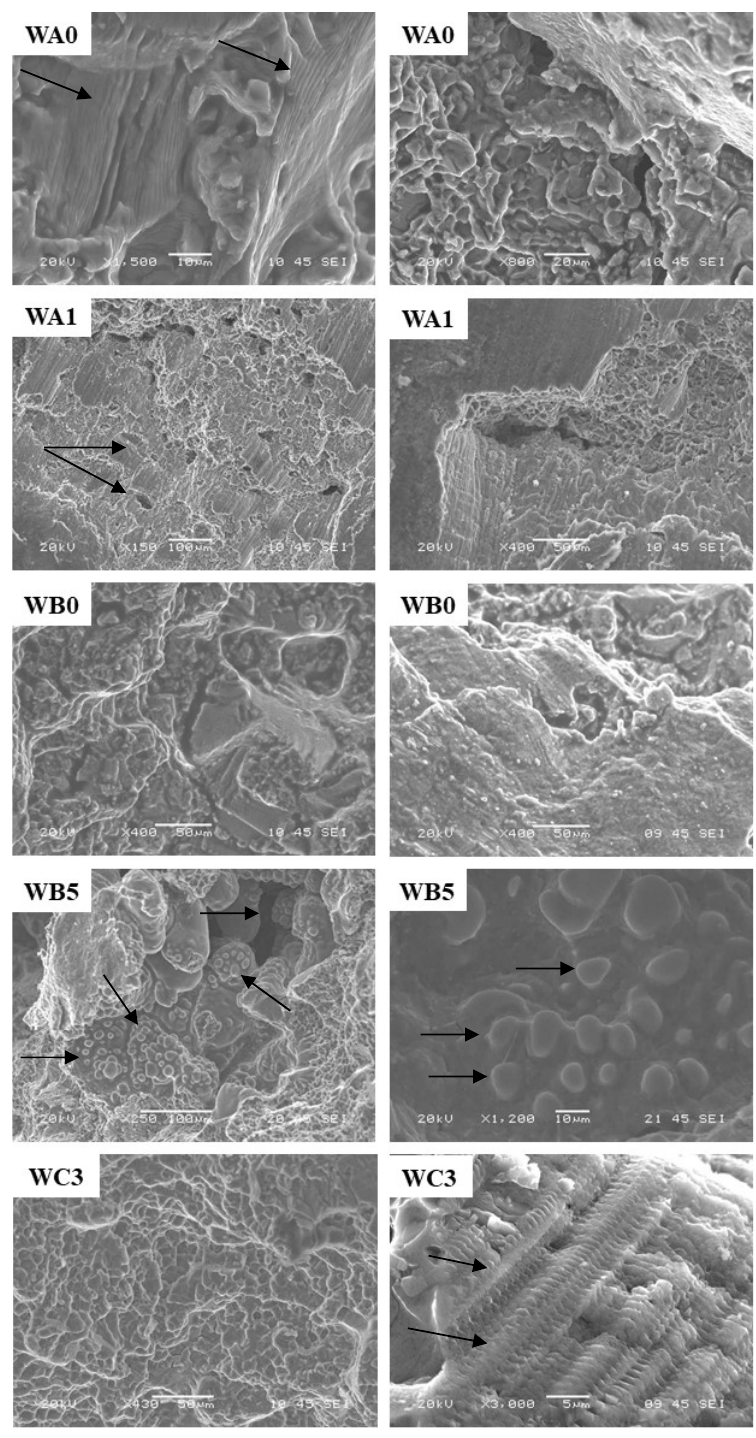
Figure 11. SEM micrographs of fracture surfaces due to fatigue failure of A357 aluminum semi solid samples heat treated by multiple thermal aging cycles.